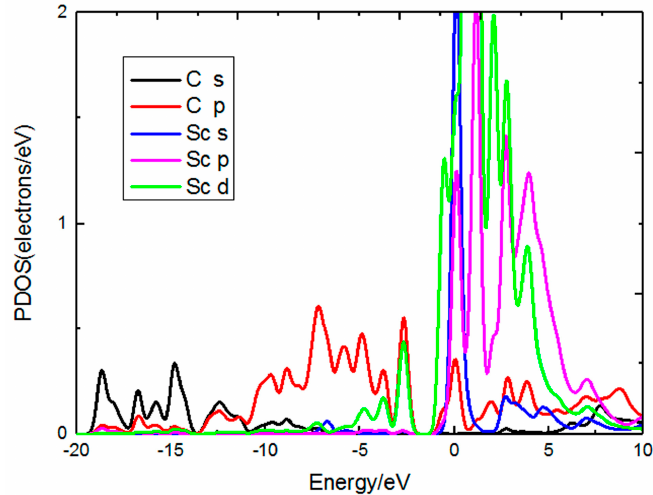
Figure 3. PDOS of Sc-decorated PG system.